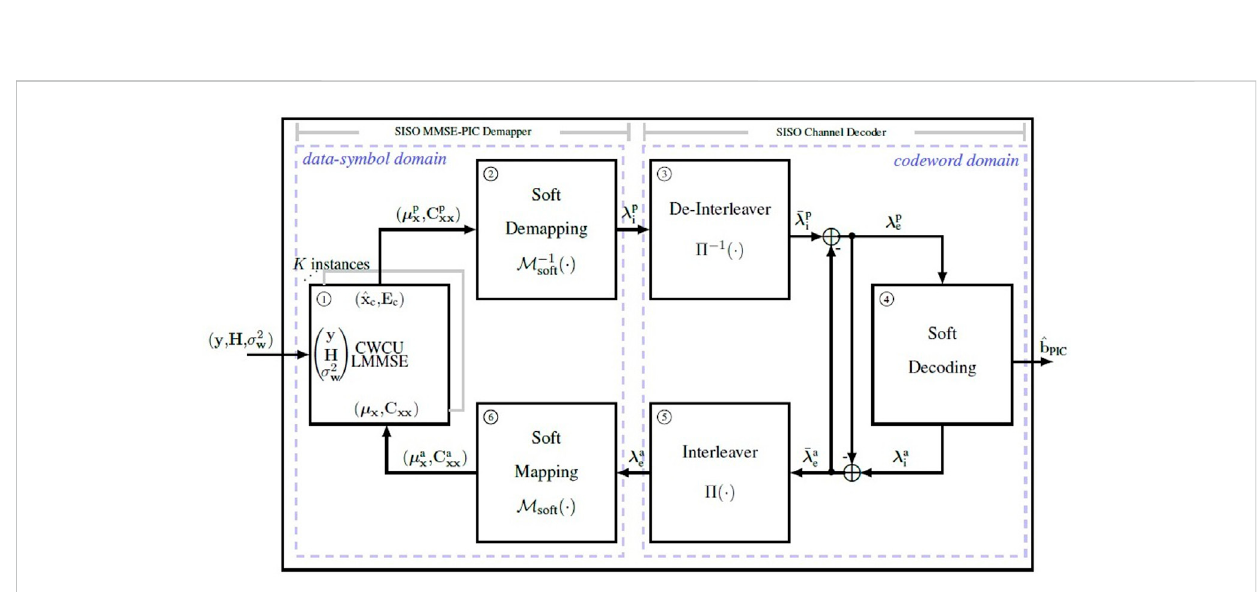
FIGURE 2 Block diagram of the Iterative MMSE-PIC